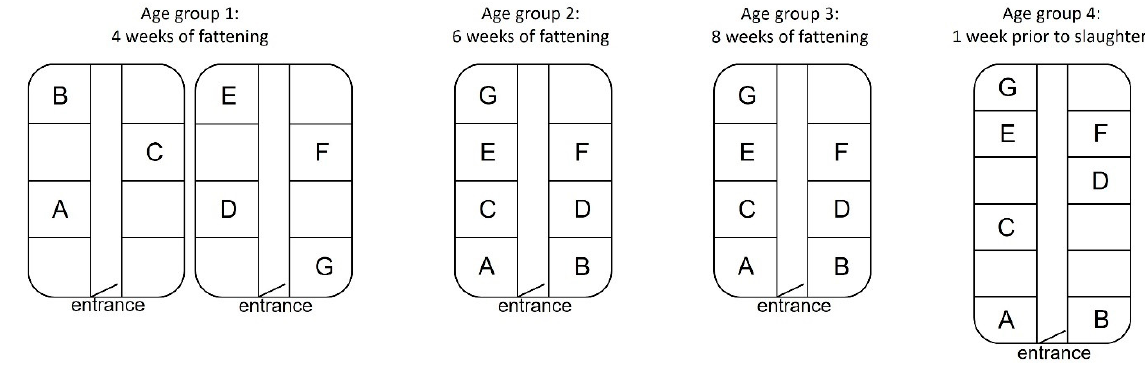
Figure 1. Location of sampled pens within farm compartments, per age group.